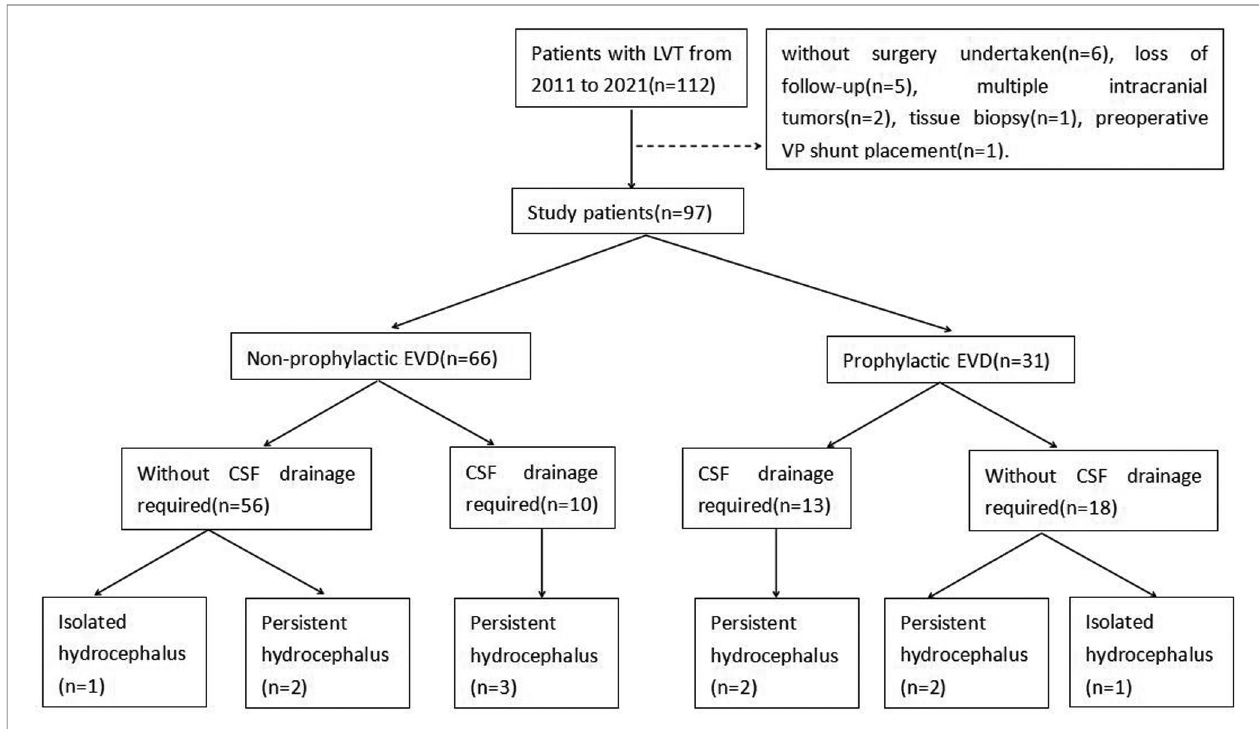
FIGURE 3 | Flow chart for the study population.